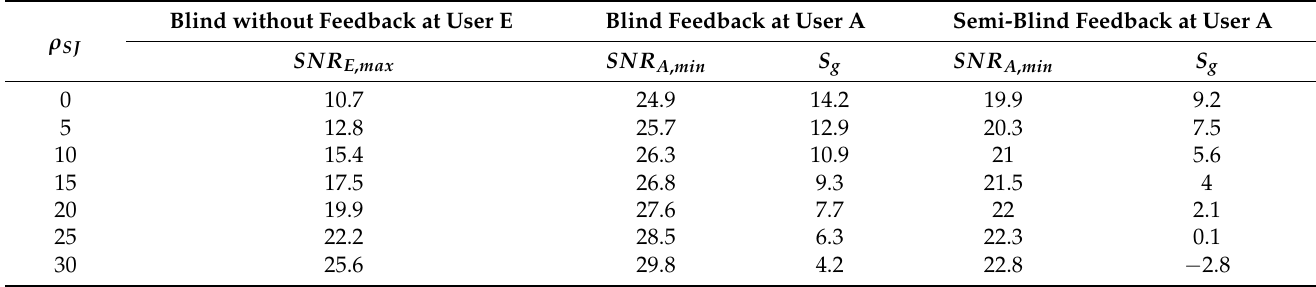
Table 4. The security gap when applying the blind scheme without feedback at user E.